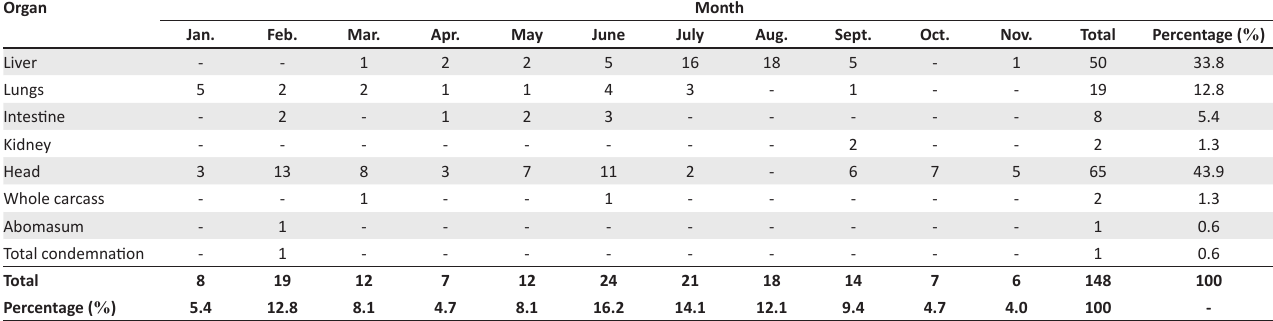
TABLE 2: Condemned organs according to month.